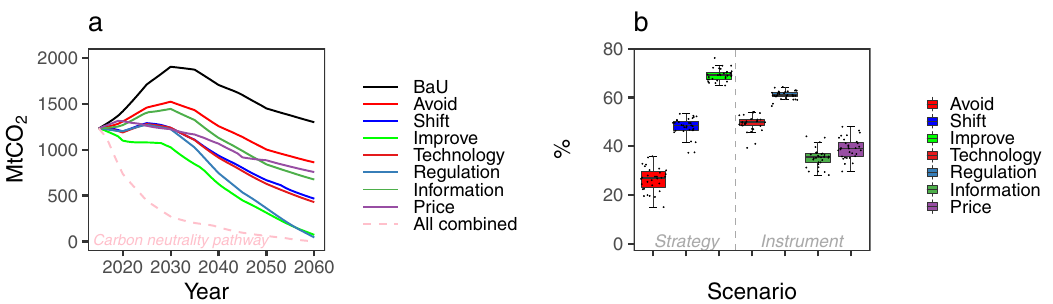
Fig. 3 CO 2 emission pathways under different strategies and instruments. a Emission trajectories under combined scenarios. b Contribution of three strategies and four instruments to achieving carbon neutrality by 2060. In the box plot, data are presented as median and minimum/maximum values in 31 provinces. The box shows fi rst and third quartile, and the whiskers are the maximum and minimum